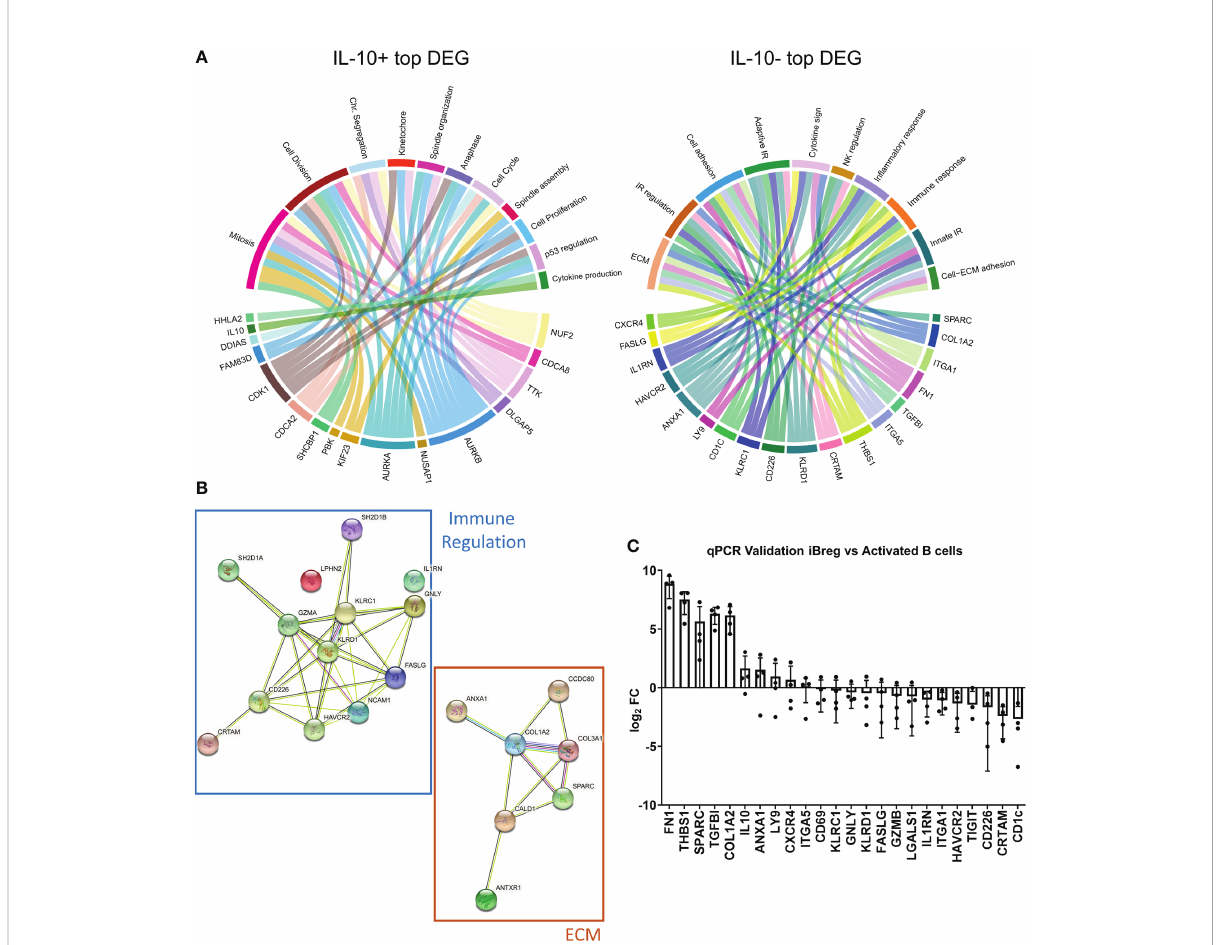
FIGURE 5 IL-10 - DEG involved in extracellular matrix organization are signi fi cantly upregulated in total iBreg when compared to activated B cells (A) Chord diagrams show biological processes of the top 20 DEG according to adjusted p-value, recapitulating similar biological processes to those identi fi ed in analysis involving all DEG. (B) Protein interactions of top DEG showing clear aggrupation in two functional networks of immune regulation and extracellular matrix genes. (C) qPCR validation of identi fi ed cell markers comparing expression between iBreg and activated B cells. Markers involved in extracellular matrix organization have clear distinct expressions on iBreg, while immune related markers have similar expressions or are downregulated in iBreg. Positive logFC values represent higher expression in iBreg compared to activated B cells. Cells from 2 MSC donors and 4 Tonsil donors were used for